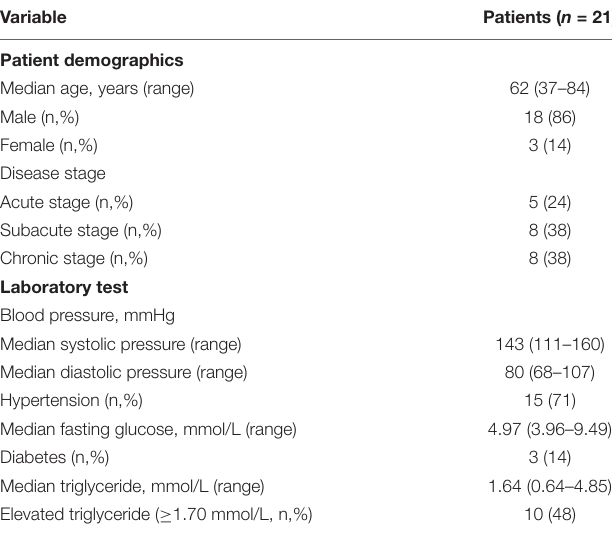
TABLE 1 | clinical characteristics of patients at admission ( n =